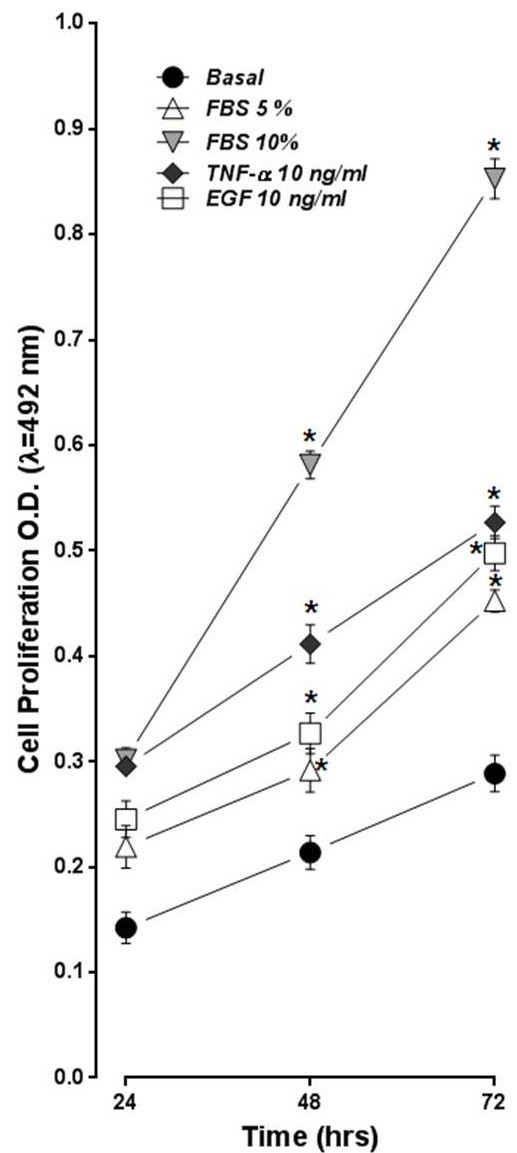
Rat ASMC proliferation in response to FBS, EGF and TNF-α. ASMC (1 × 103 cells/well) were cultured in 96 wells plates at 37°C/5%CO2 for 24, 48 and 72 hrs in a medium without FBS (basal; ●), in presence of 5% FBS (∆), 10% FBS (▼), EGF 10 ng/mL (□), TNF-α 10 ng/mL (♦). Cell proliferation was determined using a colorimetric method (MTS-PMS), measuring Optical Density (O.D.) at λ = 492 nm. Data is the mean ± ES of n = 5 experiments for triplicate. The proliferation responses of each mitogen concentration vs. basal was significant (*) p < 0.05.